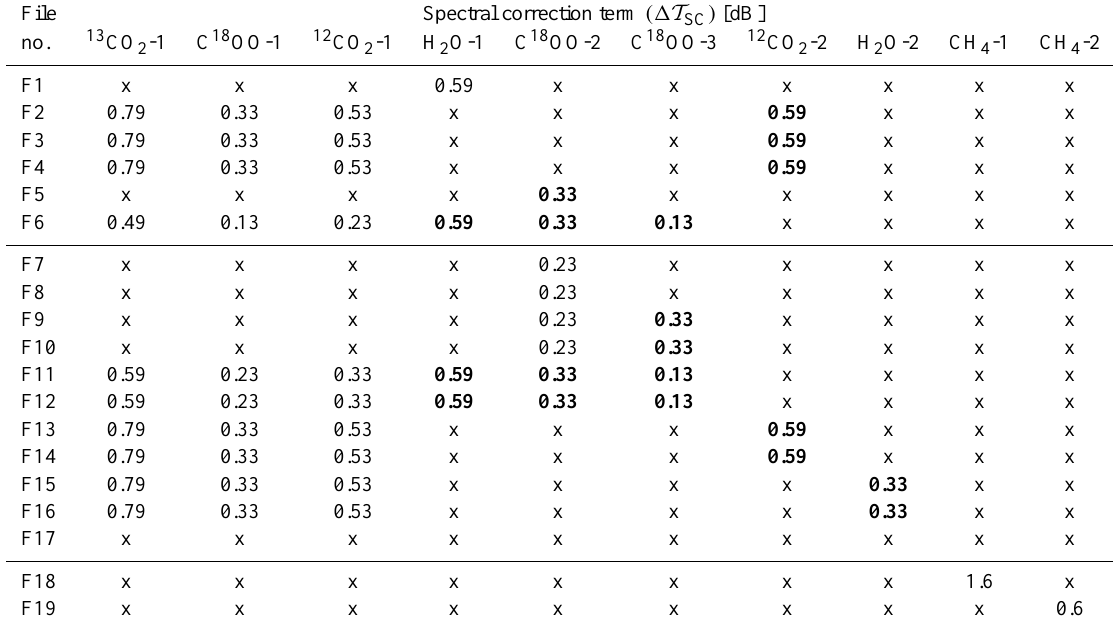
Table 5. Spectral correction terms (cid:49) T SC estimated for the 10 chosen GHG absorption lines of the 19 IR-laser link data files available for retrieval processing. An uncertainty of ± 0 . 1dB was co-estimated for the (cid:49) T SC best-estimate values of 0.79, 0.59 and 0.53, of ± 0 . 09dB for 0.49, of ± 0 . 08dB for 0.33 and 0.23, and of ± 0 . 07dB for 0.13, respectively. The CH 4 (cid:49) T SC values were estimated as 1.6 and 0.6, with an uncertainty of ± 0 . 13dB. The numbers in bold represent the measurements with laser L1, and the upright numbers those with laser L2; the CH 4 measurements were performed with laser